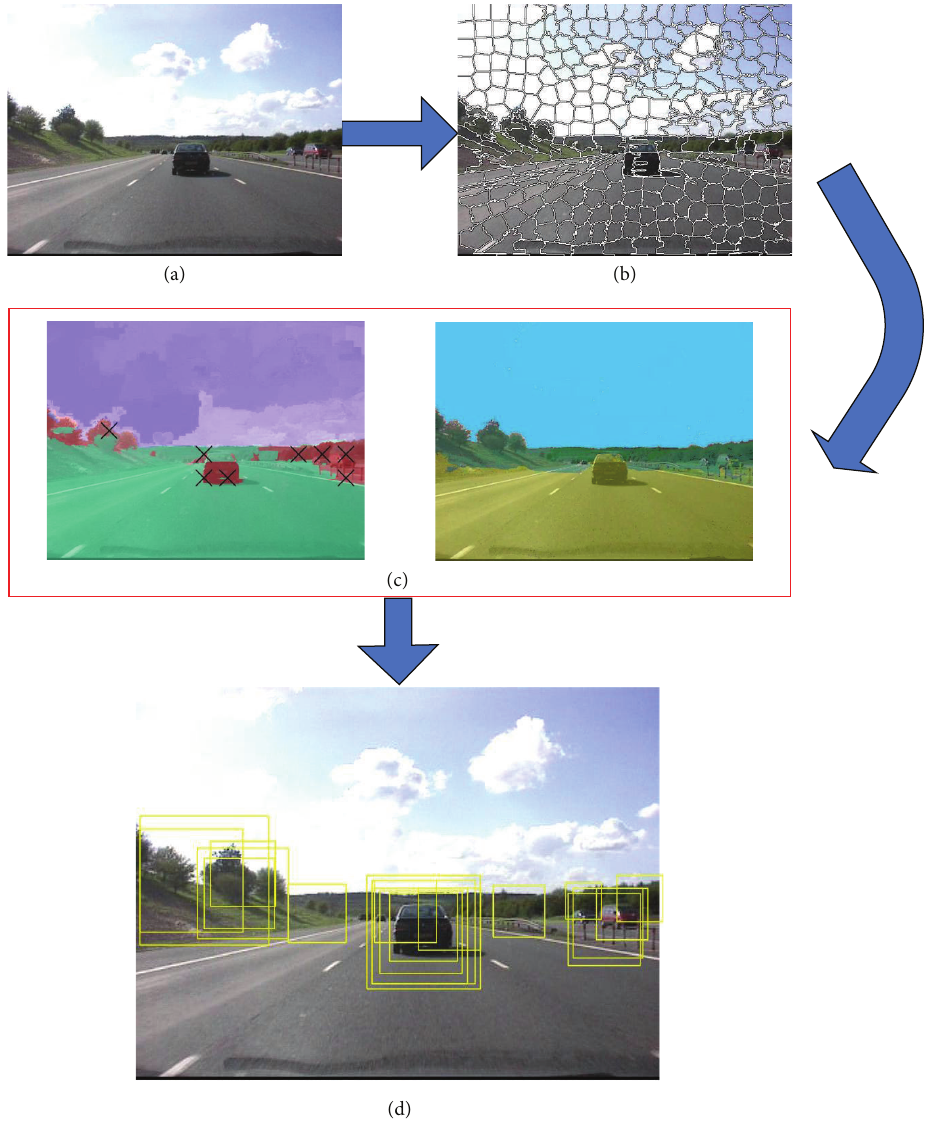
Figure 2: One sample of vehicle candidate generation.